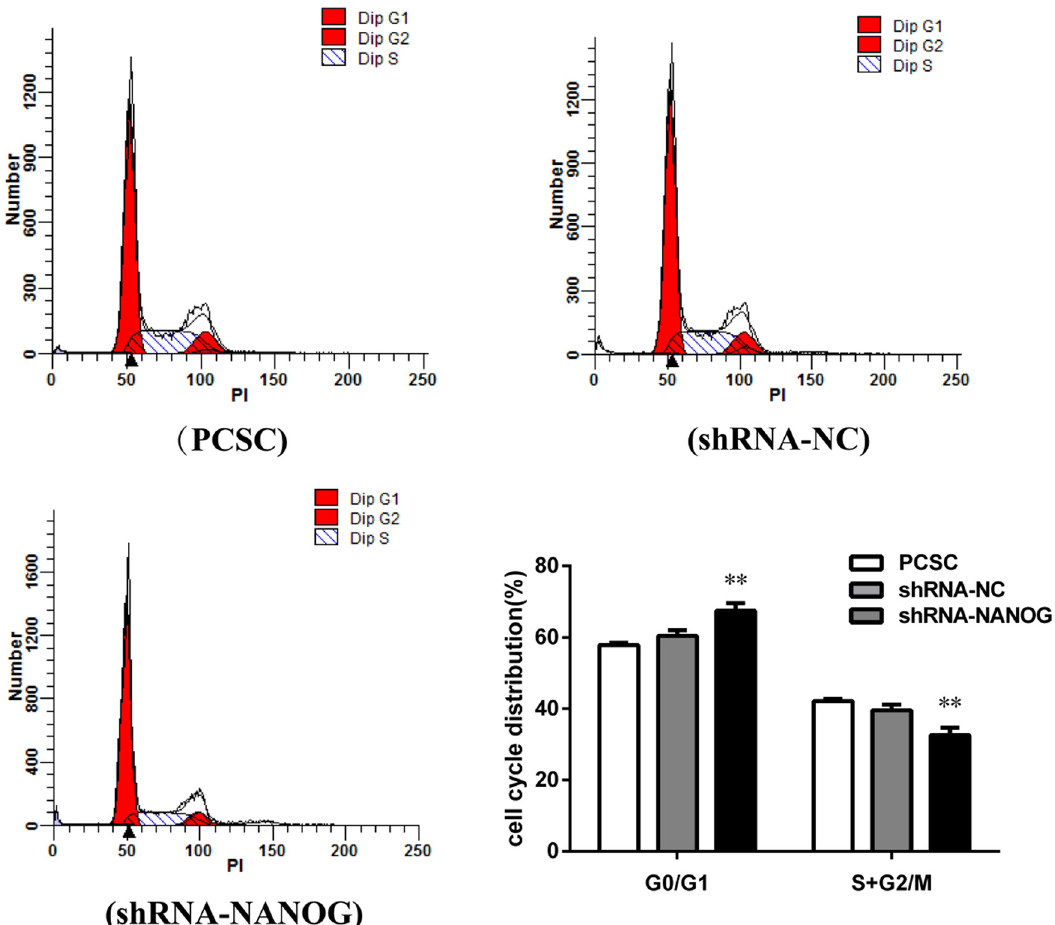
Figure 3: Interfering with NANOG in PCSCs blocks the cell cycle. ( a and b ) After the transfection of PCSCs with shRNA - NANOG, fl ow cytometry was performed to detect cell cycle conditions. The proportion of the G0/G1 - phase cells and the S + G2/M - phase cells is signi fi cantly upregulated ( * p < 0.05, ** p < 0.01, and *** p < 0.001 ) and signi fi cantly downregulated ( * p < 0.05, ** p < 0.01, and *** p < 0.001 ) ,